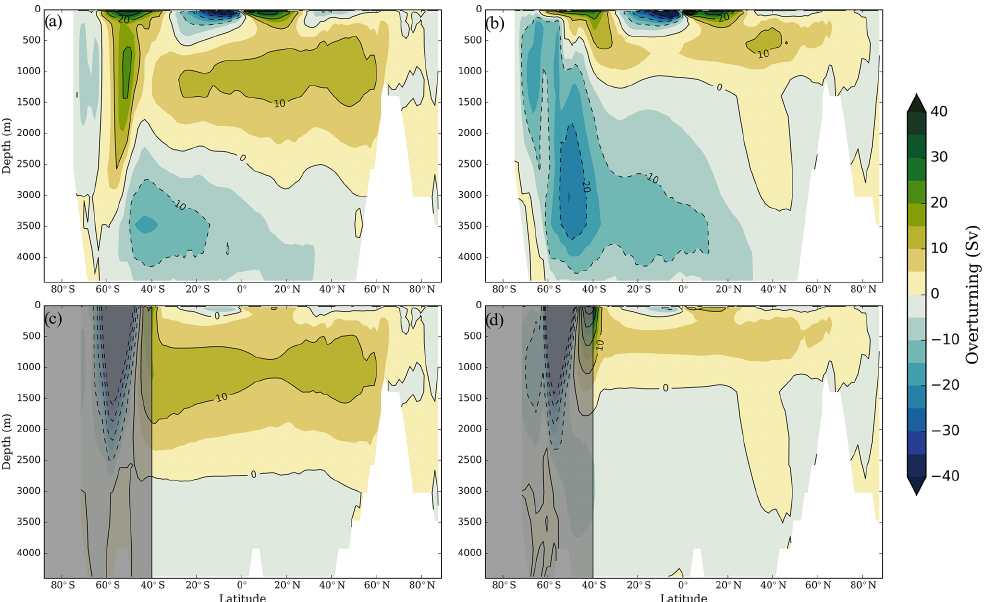
Figure 3. The upper panels depict the total meridional overturning stream function (Sv) for the global ocean in the (a) Cpl-PI and (b) Cpl- LGM simulations. The bottom panels depict the total meridional overturning stream function (sv) for the Atlantic ocean in the (c) Cpl-PI and (d) Cpl-LGM simulations. Note that those latitudes corresponding to the Southern Ocean are obscured for (c, d) in the Atlantic Ocean, as these overturning velocities are invalid considering that waters can exit to the east and west and that the stream function does not account for these